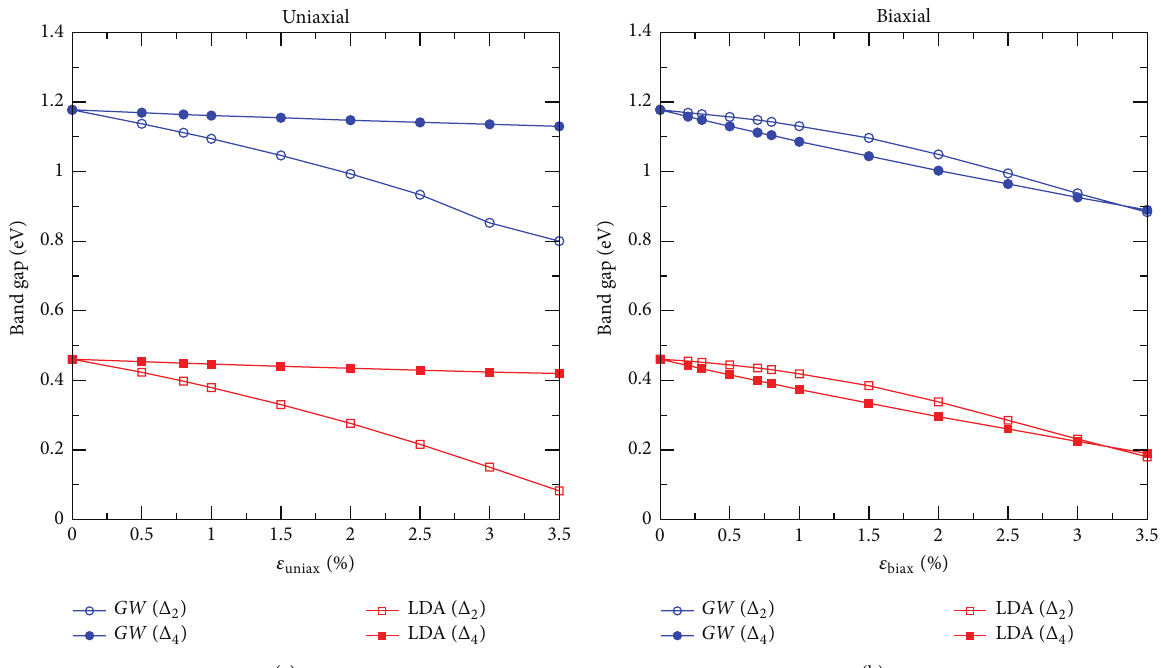
Figure 3: Band gap of silicon versus strain for tensile uniaxial (a) and biaxial (b) strains along the [110] direction within DFT-LDA and 𝐺𝑊 for both the Δ 2 and Δ 4